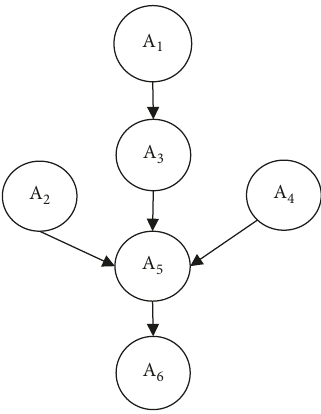
Figure 1: A sample of the Bayesian Network (BN) with six nodes.